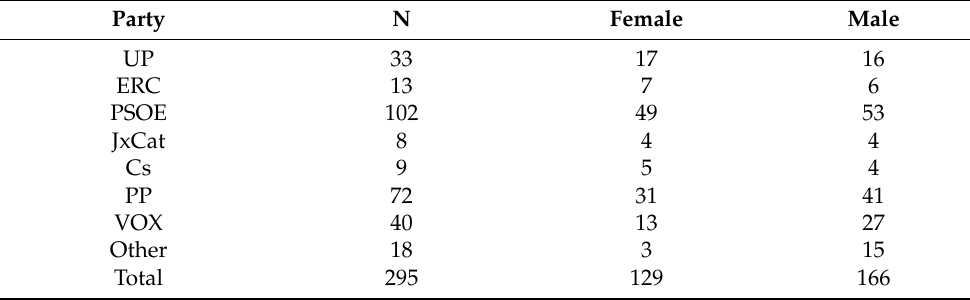
Table 2. Breakdown of Spanish Members by party.